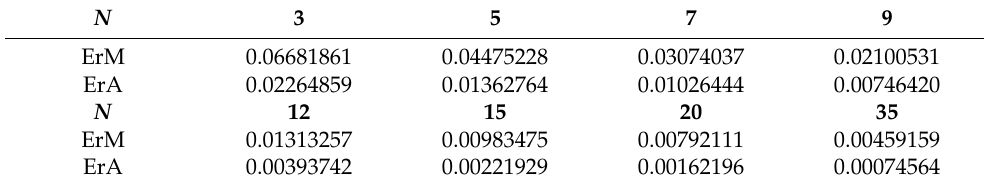
Table 2. Errors between the reconstructed PDE surfaces and the original polygon model. N 3 5